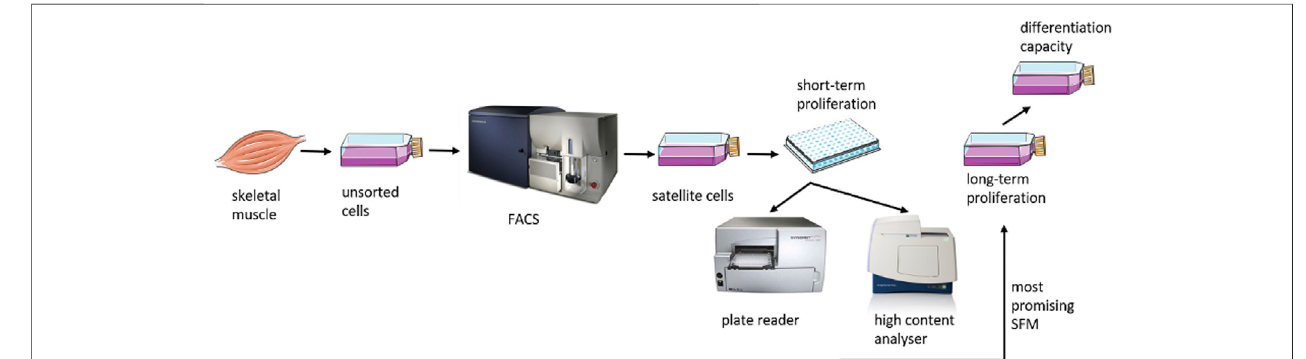
FIGURE 1 | Schematic overview of the